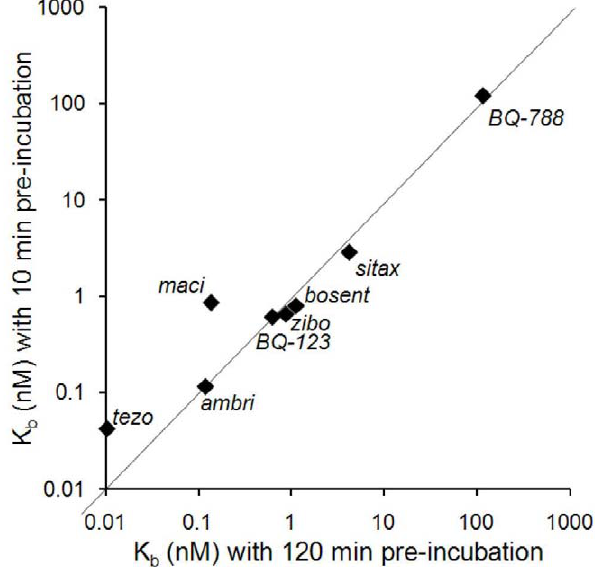
Figure 2. Antagonistic potency and apparent association kinetics of different ERAs using calcium release assays in PASMC. Cells were pre-incubated with antagonist dilution series for 10 min or 120 min and then stimulated in the FLIPR with ET-1 (EC 50 – EC 70 ). IC 50 values were calculated from fluorescence peak responses and transformed into K b values as described in Methods. Correlation scatter plot of the K b values generated for 10 min versus 120 min antagonist pre-incubation times (geometric means of n=6 determinations).